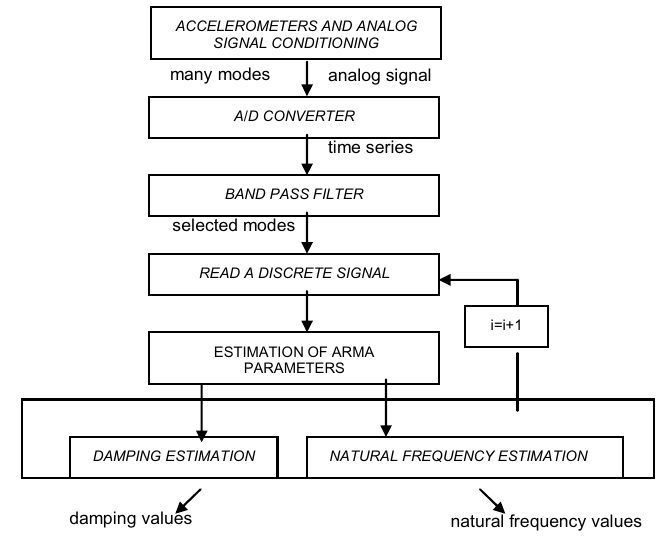
Fig. 4. Acceleration signals recorded during flight test of TS-11 Iskra military jet aircraft points maximum) and with a signal time window width of 512 samples. In the present version, the flutterometer is equipped with a hardware accelerator capable of separating two vibration modes in each of the two input signals (four channels